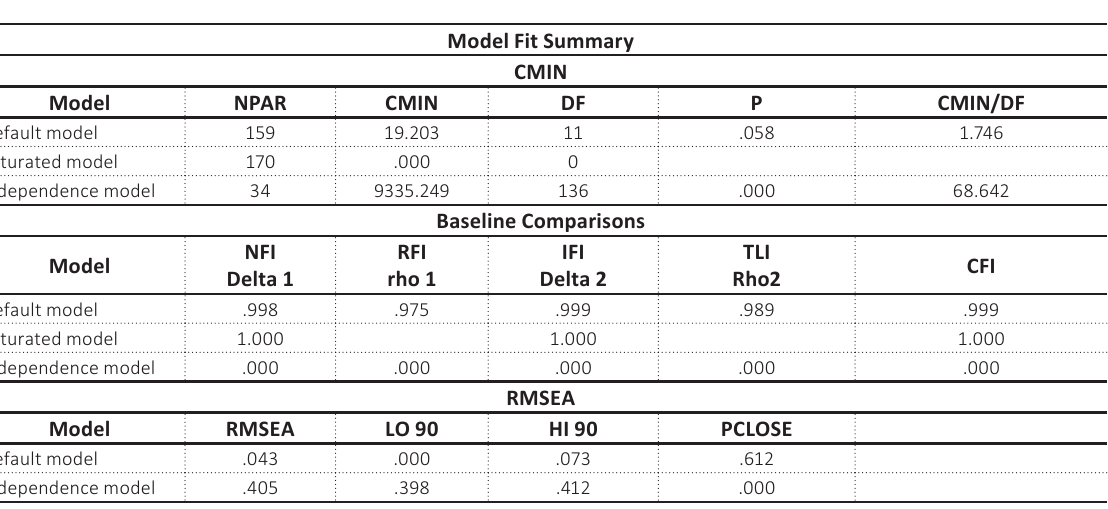
Figure 3. Simulated SEM configuration Table 5. Simulated SEM statistics